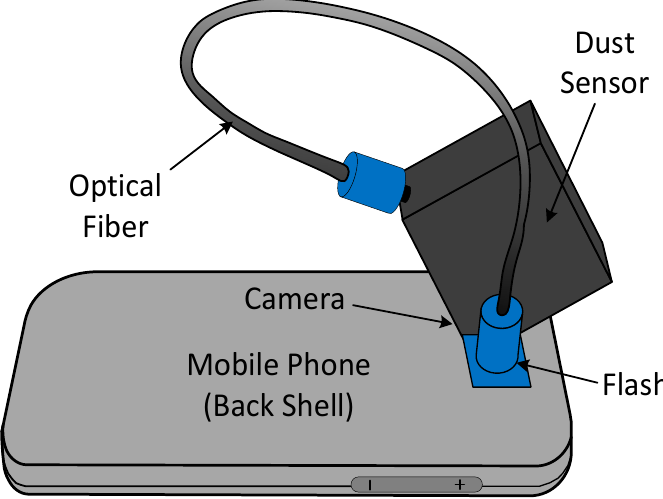
Figure 4. The third-generation design of the optical sensor.